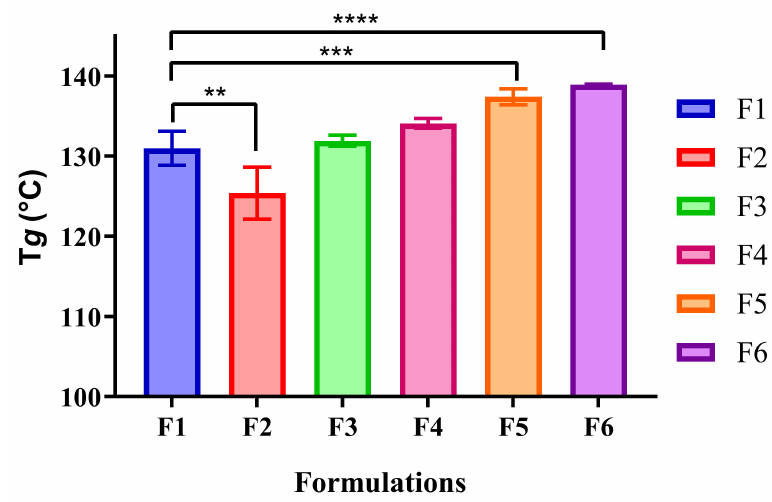
Figure 1. The T g of p(HEMA) (control (F1), F2, F3, F4, F5, and F6). Values present the average mean ± SD, n = 3., ** p < 0.01, *** p < 0.001, and **** p < 0.0001 significant difference between formulations.